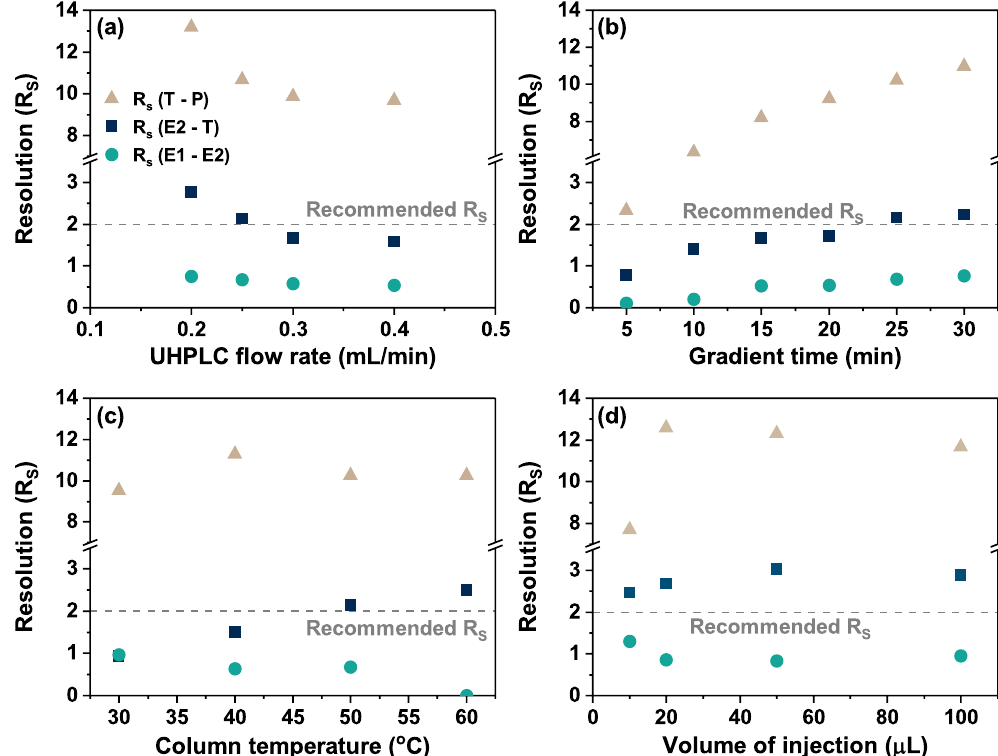
Figure 3. Influence of ( a ) UHPLC flow rate, ( b ) methanol-water gradient time, ( c ) column temperature, ( d ) volume of injection on the peak resolution of E1–E2, E2–T and T–P pairs obtained from a single hormone elution. A recommended R S > 2 for adjacent peaks was marked with a dashed